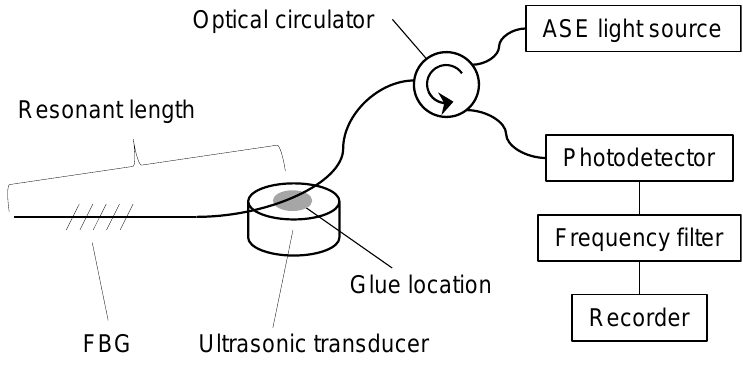
Figure 1. Experimental setup for FBG ultrasound detection without an optical filter for demodulation. Optical circulator ASE light source FBGResonant length Photodetector Frequency filter transducerGlue Recorder Ultrasonic